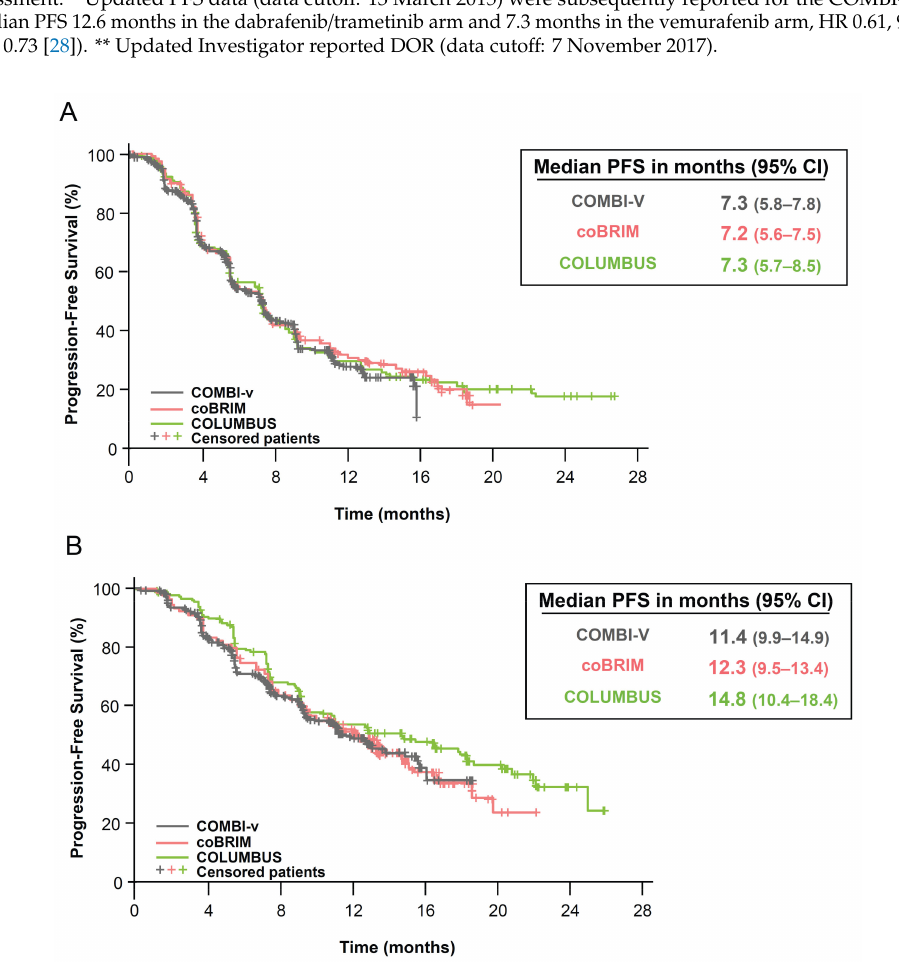
CI indicates confidence interval; D / T, dabrafenib plus trametinib; DOR, duration of response; E / B, encorafenib plus binimetinib; HR, hazard ratio; NE, not estimable; NR, not reached; ORR, objective response rate; OS, overall survival; PFS, progression-free survival; V, vemurafenib; V / C, vemurafenib plus cobimetinib. * Per investigator assessment. † Updated PFS data (data cuto ff : 13 March 2015) were subsequently reported for the COMBI-v trial